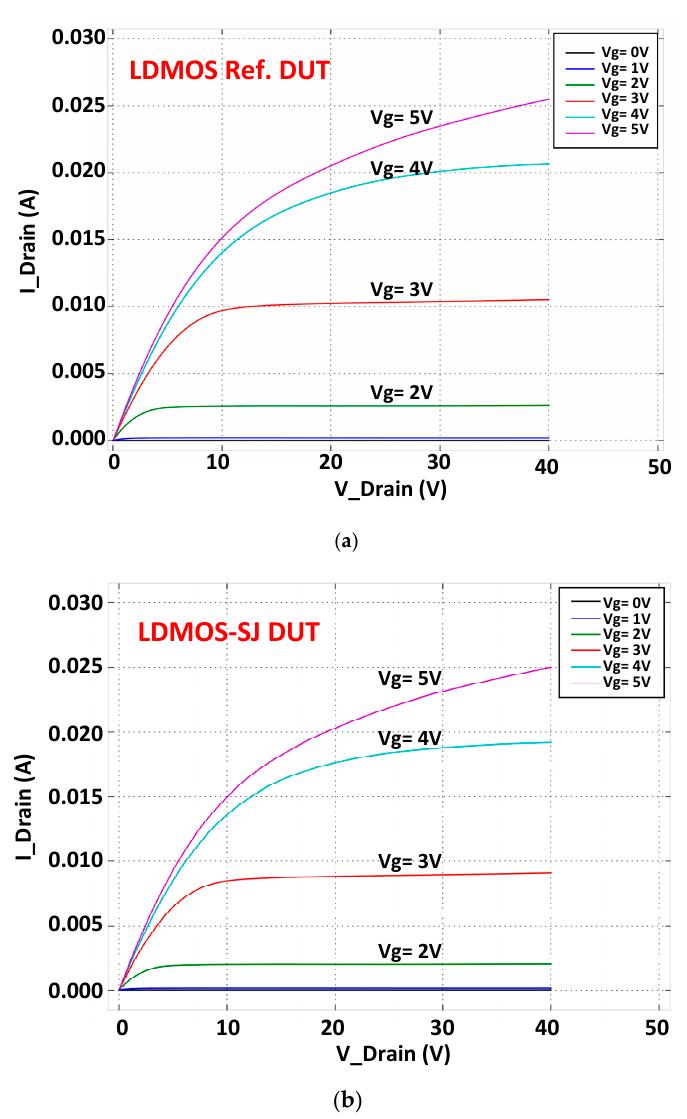
Figure 8. The normal output I-V characteristics of ( a ) UHV 300 V ref. nLDMOS, and ( b ) nLDMOS-SJs type-M8 device with X = 10 μ m.